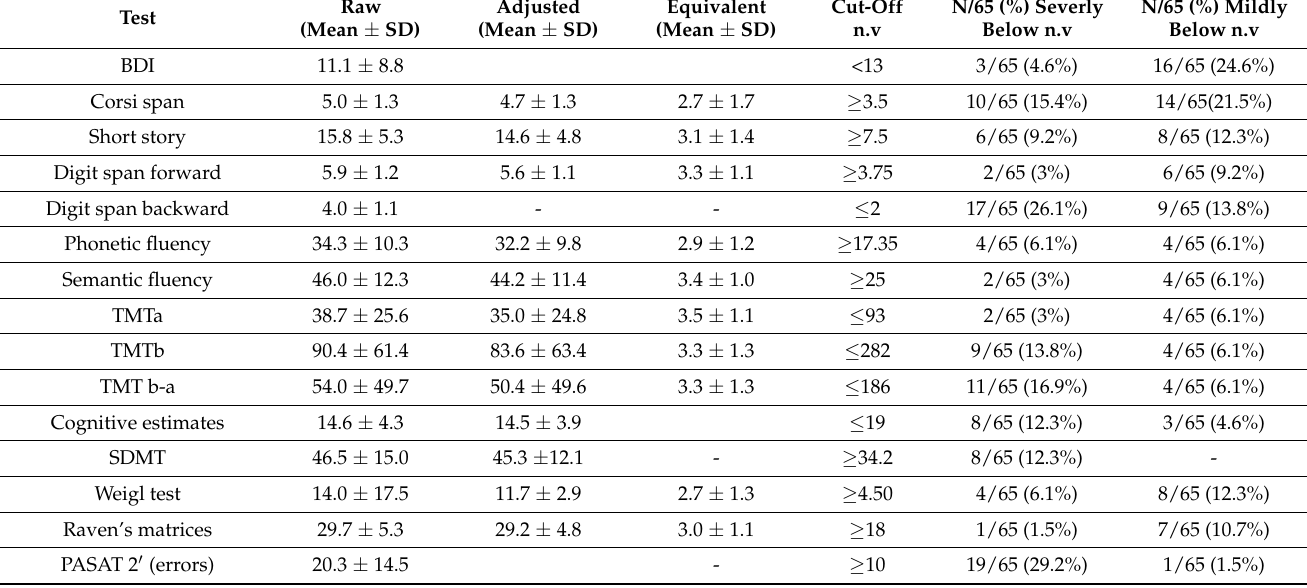
Table 2. Neuropsychological evaluation at